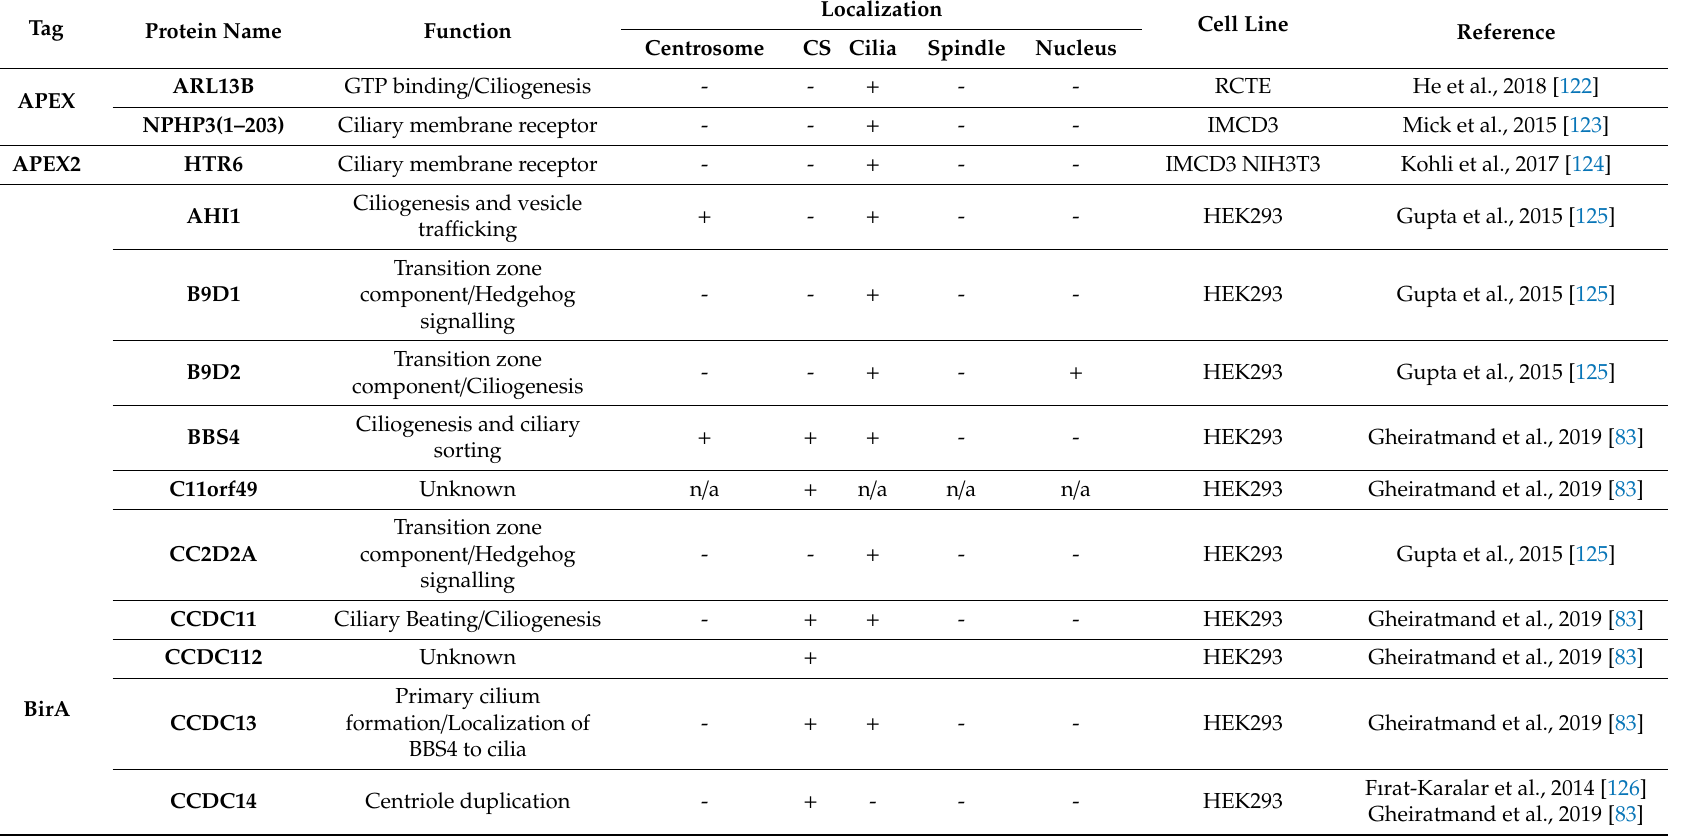
Table 2. Applications of the proximity-based labeling approaches that probed the structure and function of the centrosome / cilium complex. The table lists the bait proteins used in di ff erent proximity-based labeling methods. The following cell lines were utilized in generating their proximity interaction maps: Human embryonic kidney 293 (HEK293), Human hTERT-immortalized retinal pigmental epithelial cells (RPE1), Human renal cortical tubular epithelial cells (RCTE), Human bone osteosarcoma cells (U2OS), Mouse inner medullary collecting duct 3 (IMCD3), Mouse fibroblast cells (NIH3T3). Kidney and lung epithelial cells use the extracellular ciliogenesis pathway, whereas retinal pigmental epithelial cells and fibroblasts use the intracellular ciliogenesis pathway. Protein function information was derived from